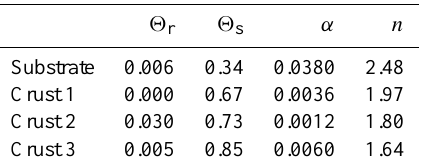
Table 1. van Genuchten fitting parameters of the corrected BSC water retention functions, 2 in m 3 m − 3 , unit of − 9 in regression analysis was hPa.